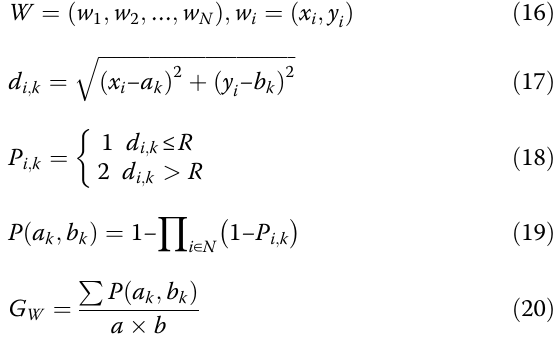
The algorithm flow for applying the improved Apriori algorithm to WSN coverage optimization of